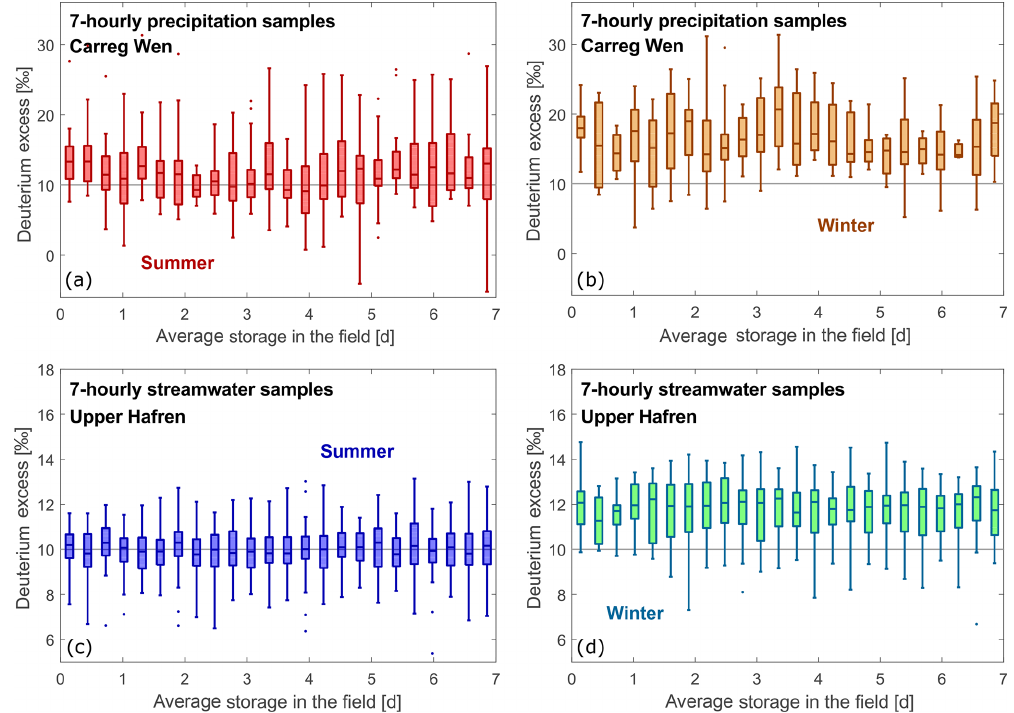
Figure 4. Variations in deuterium excess in 7-hourly samples as a function of the length of time that they were stored inside the field autosamplers. Boxplots are defined as described in Fig. 3. Axis scales differ between (a, b) and (c, d) , reflecting the greater variability in precipitation deuterium excess. There is no systematic effect of storage duration on deuterium excess during either summer (May–October, a, c ) or winter (November–April, b, d ), indicating that any evaporative fractionation during storage was negligible. Deuterium excess in streamwater samples is systematically lower during summer, likely reflecting real-world seasonal variations in deuterium excess (see also Fig.